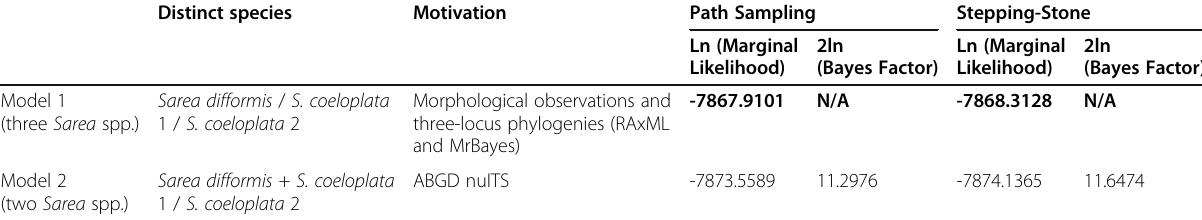
Table 1 Species delimitation hypotheses in